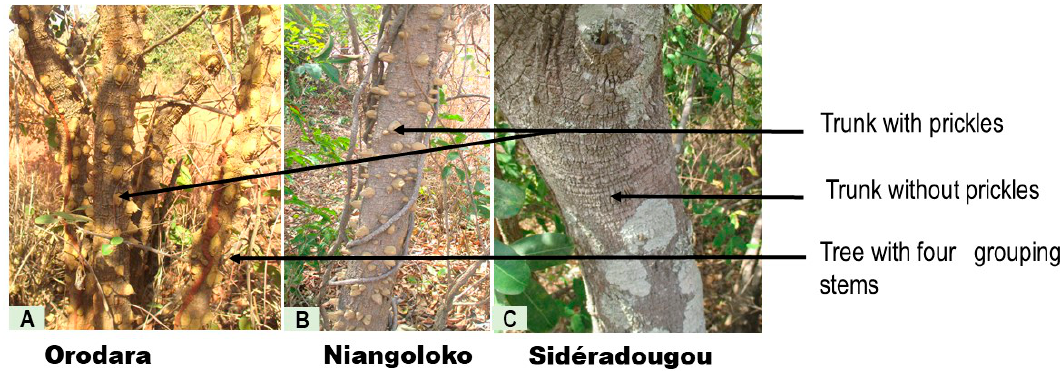
Figure3. Viewof Z.zanthoxyloides stemsandtrunkfromOrodara( A ),Niangoloko( B ),andSid é radougou Figure 3. View of Z. zanthoxyloides stems and trunk from Orodara (A), Niangoloko (B), and ( C ) evaluated in the same seasonal Sidéradougou (C) evaluated in the same seasonal period.